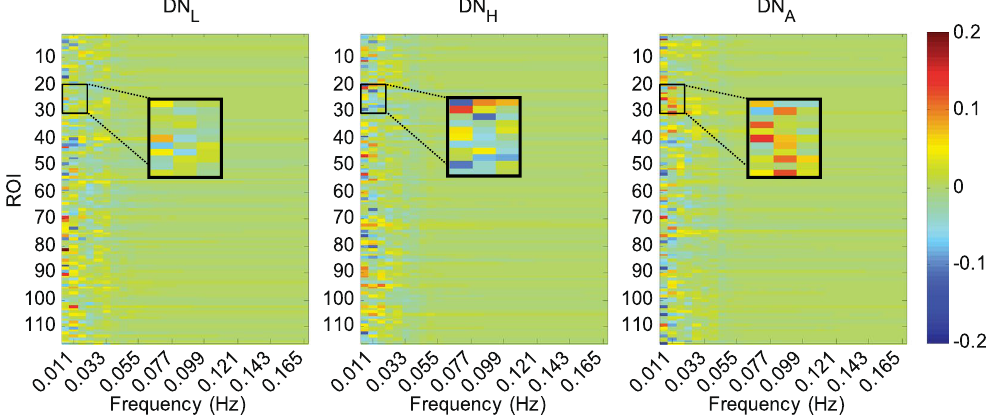
Figure 6. Principal component coefficients corresponding to the most discriminative features selected by LASSO for DN L , DN H and DN A , respectively. For better visualization and comparison among the different networks for the different spatial-frequency characteristic of the selected features, a small patch at the same location of the three matrices was zoomed in.